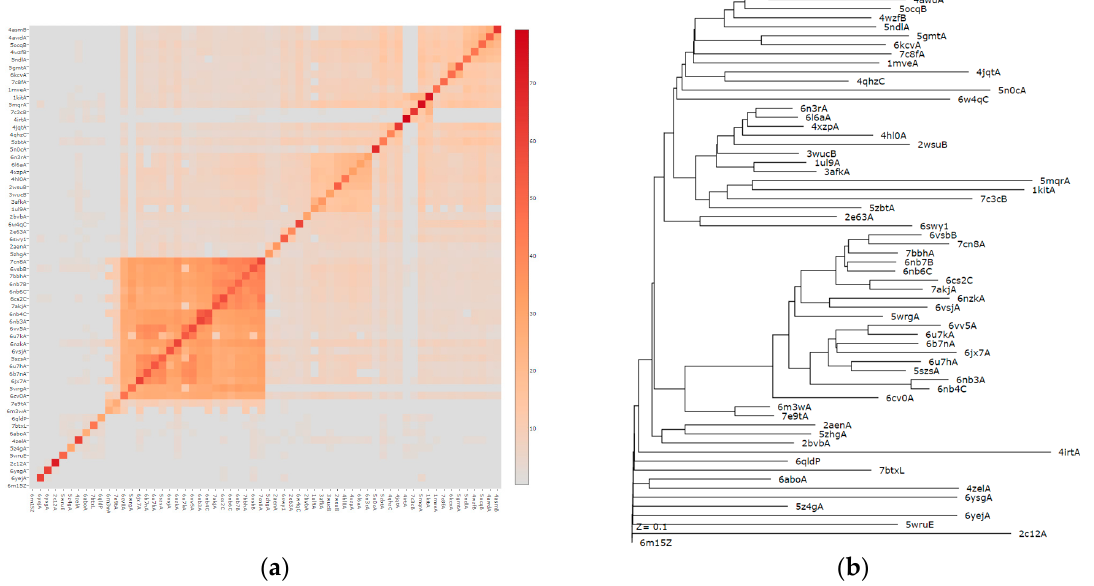
Figure 5. ( a ) Similarity matrix, based on Z-score. The query structure is closest to pangolin structures. ( b ) Structural similarity dendrogram. The presence of the query structure with the PCoV_GX S structure suggests that pangolin-CoV is the closest relative of SARS-CoV-2. The similarity matrix can be further divided into three main clusters. The 18 similar structures (PIDs: 7CN8, 7BBH, 6NB7, 6NB6, 6CS2, 7AKJ, 6NB4, 6NB3, 6VV5, 6U7K, 6NZK, 6VSJ, 5SZS, 6U7H, 6B7N, 6JX7, 5WRG and